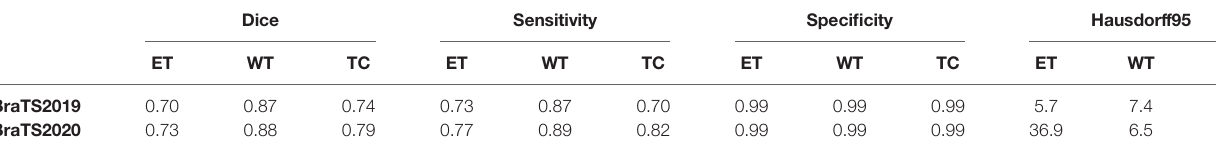
TABLE 2 | Segmentation results of different models for BraTS 2019 and BraTS